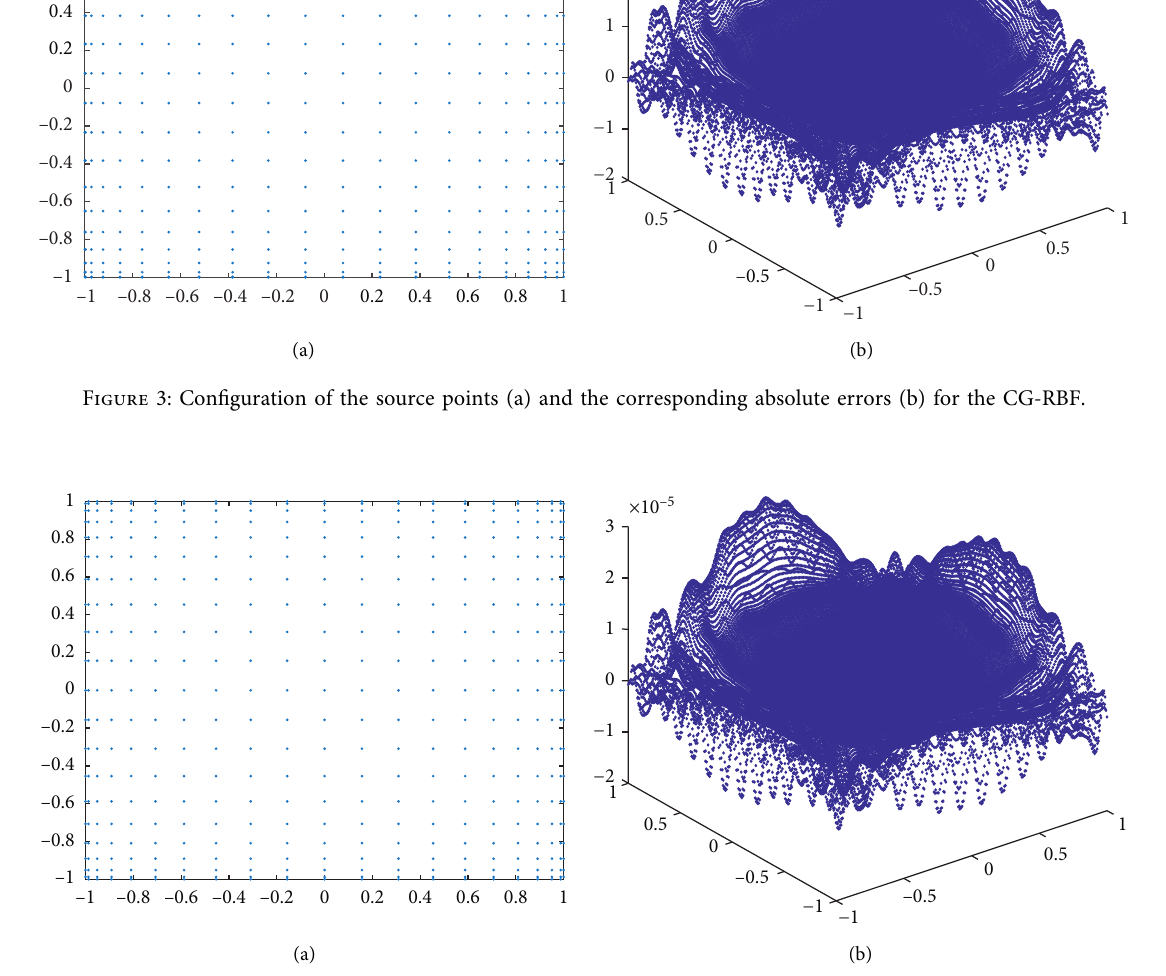
Figure 4: Configuration of the source points (a) and the corresponding absolute errors (b) for the